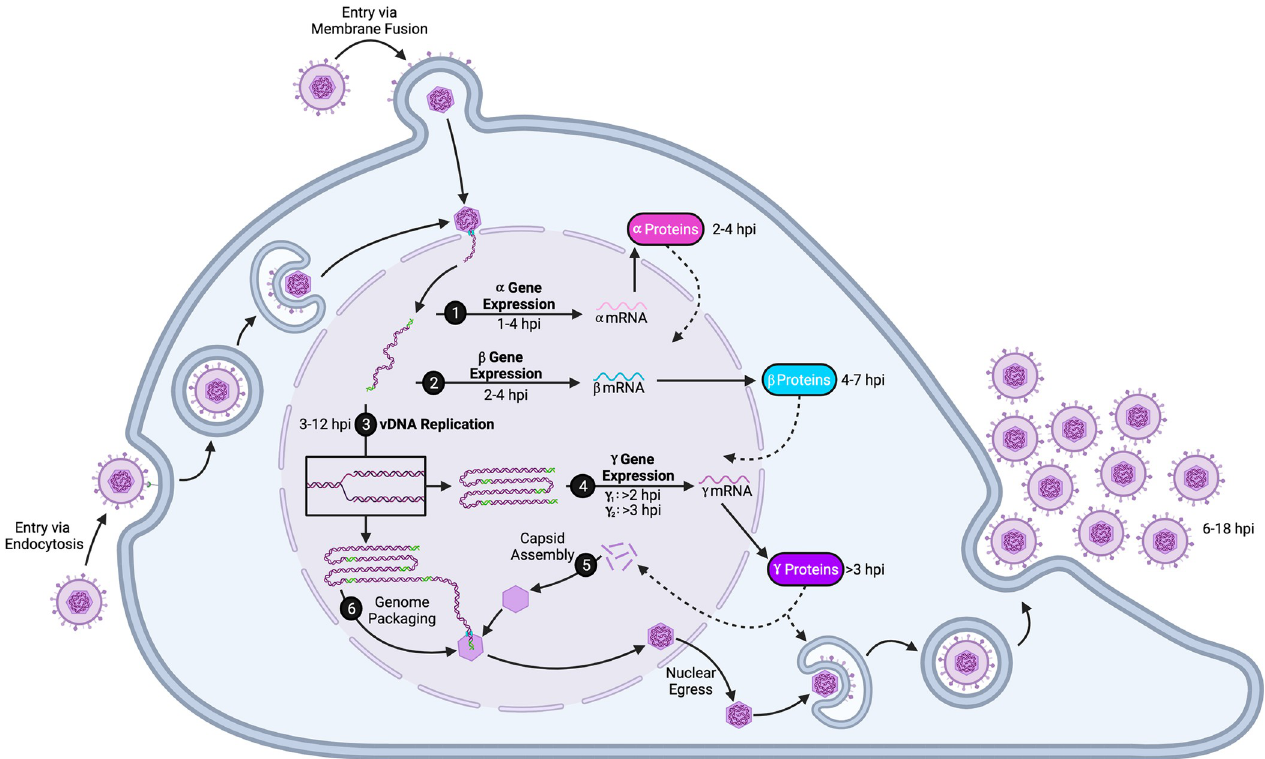
Fig 1. The HSV-1 infectious cycle. AU : AbbreviationlisthavebeencompiledforthoseusedinFigs 1 and 2 : Pleaseverifythatallentriesarecorrect : Virions enter the cell via fusion with the host-cell membrane or endocytosis. The capsid docks at the nuclear pore and viral DNA enters the nucleus through the portal in the capsid (drawn in teal above). The HSV-1 genome is then expressed: (1) α genes are expressed upon entry; (2) α gene products drive β transcription; (3) after β protein expression, vDNA replication occurs; (4) γ 1 gene expression is amplified, and γ 2 gene expression is enabled by DNA replication; (5) capsid proteins, which are γ gene products, assemble; and then (6) replicated genomes are packaged into capsids through the portal. Packaged capsids leave the nucleus through nuclear egress and move through the secretory pathway, obtain an envelope spiked with viral glycoproteins, and nascent virions are released from the cell by exocytosis. Transcript and protein timing pictured above are approximated based on previous studies [11,16]. Note that the viral genome forms concatemers during replication as indicated above, and unit length genomes (flanked by green) are packaged into capsids. Also note that some models indicate that the viral genome circularizes after entry into the nucleus. Tegument proteins were omitted for simplicity. Figure created using www.biorender.com. hpi, hours post infection; HSV-1, herpes simplex virus